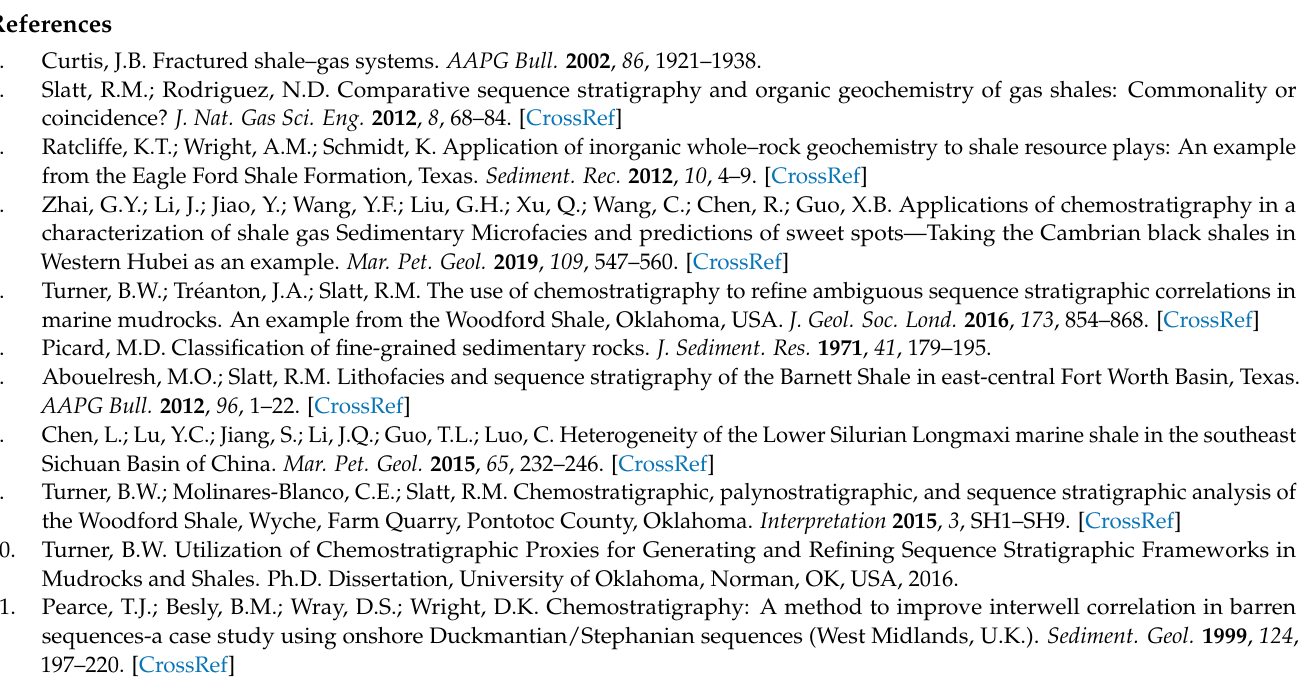
Figure A1. The dendrograms of constrained clustering analysis ( a ) derived from detrital chemofacies; ( b ) from authigenic chemofacies; and ( c ) from redox-organic chemofacies.